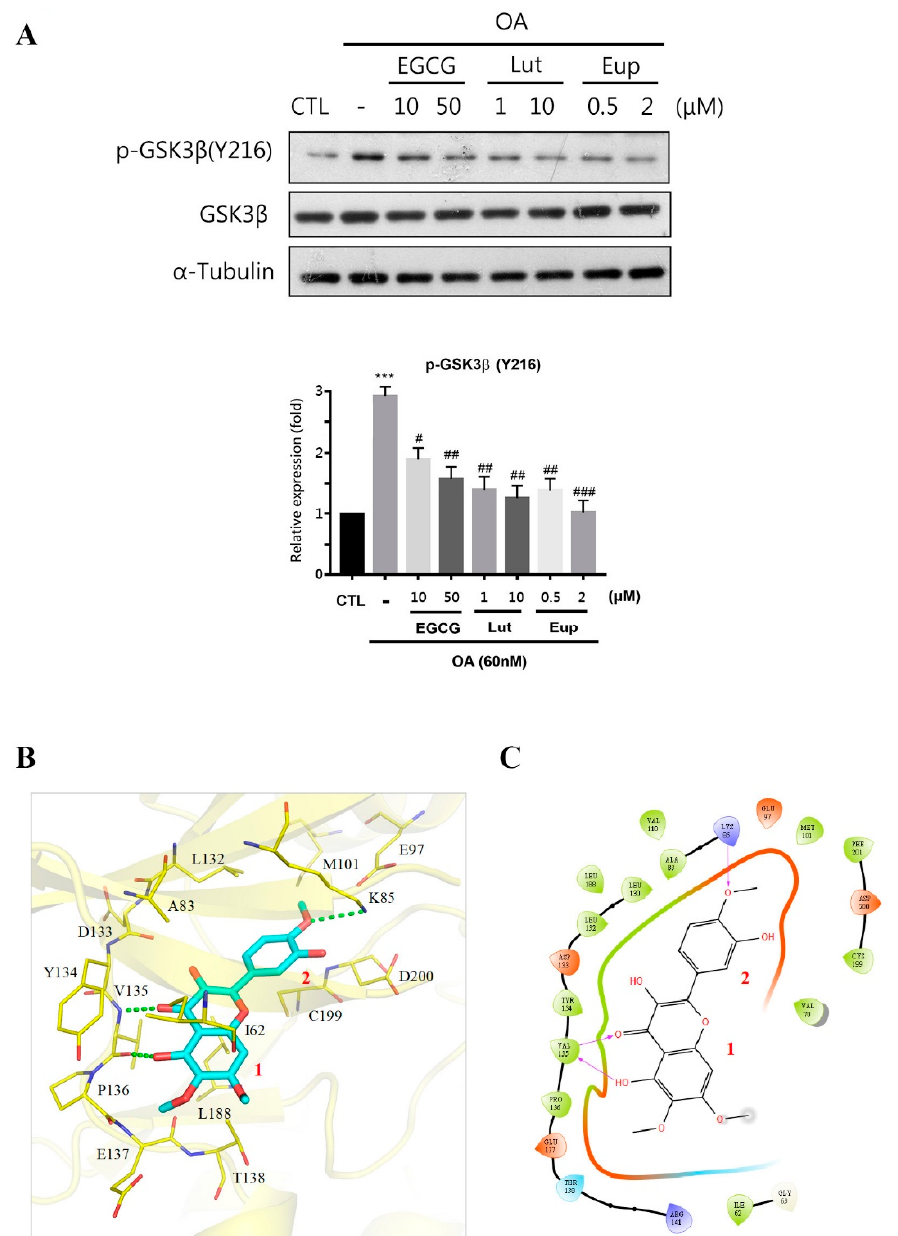
Figure 6. Eupatin significantly inhibited GSK3 β activation. ( A ) Neuro-2a cells were incubated with indicated concentrations of EGCG, luteolin, or eupatin for 24 h and subsequently underwent 6-h incubation with 60 nM OA. Western blotting of cell lysates was performed using the indicated proteins. The results are presented as the mean ± standard error of the mean of three independent experiments. *** p < 0.001 for comparisons with the control group; # p < 0.05, ## p < 0.01, and ### p < 0.001 for comparisons with the OA-treated group. ( B ) The docking pose of eupatin (blue) in the GSK3 β active site (yellow). Hydrogen bonds are indicated by dashed green lines, and active site residues are labeled. The benzopyran and benzene rings are labeled as Groups 1 and 2, respectively. ( C ) Two-dimensional interaction diagram of eupatin and GSK3 β . Arrows denote hydrogen bonds, and residues in green indicate hydrophobic interactions.